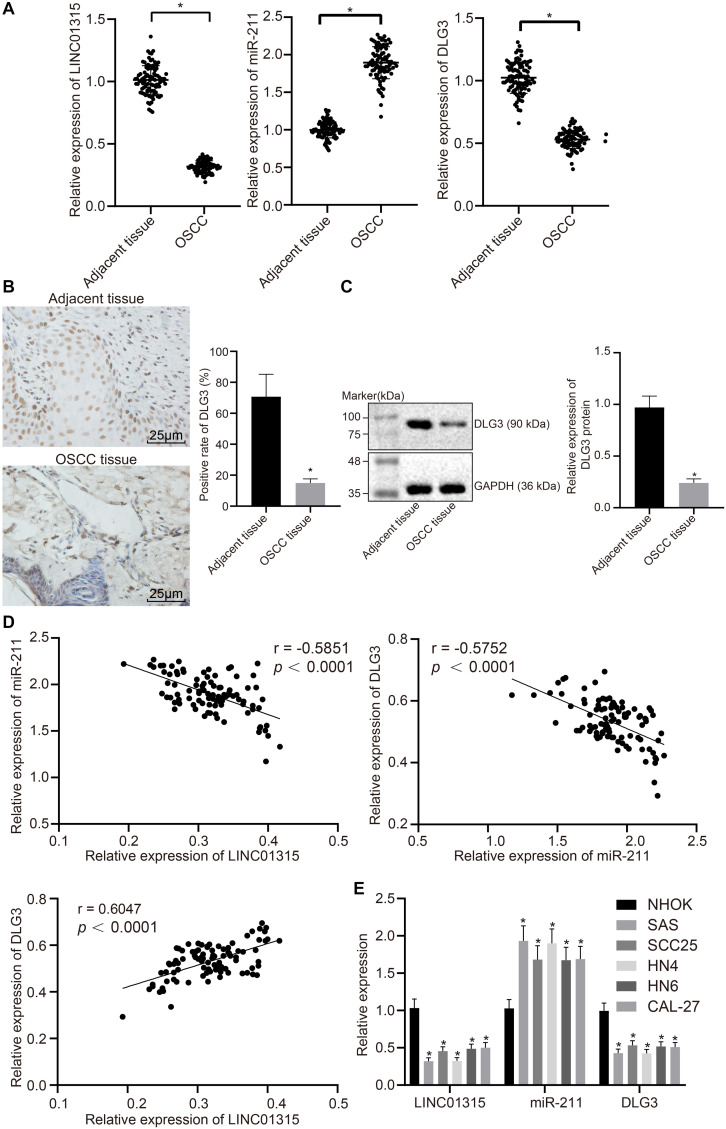
Decreased levels of DLG3 and LINC01315 but increased level of miR-211 are identified in OSCC tissues and cells. (A) Expression pattern of LINC01315, and miR-211 and DLG3 mRNA in OSCC tissues and adjacent normal tissues of patients with OSCC (n = 94) evaluated by RT-qPCR; (B) DLG3 positive rate in adjacent normal tissues and OSCC tissues (n = 94) detected by immunohistochemistry (×400); (C) DLG3 protein level in adjacent normal tissues and OSCC tissues (n = 94), as determined by western blot analysis; (D) Pearson correlation analysis among LINC01315, miR-211 and DLG3 expression in OSCC tissues (n = 94); E, Expression of LINC01315, miR-211 and DLG3 in OSCC cells (SAS, SCC25, HN4, HN6, and CAL-27) and human normal oral cell NHOK, as measured by RT-qPCR. *p < 0.05 vs. adjacent normal tissues or human normal oral cell NHOK; the data between two groups were analyzed by t-test and data among multiple groups were analyzed using one-way ANOVA. The experiment was repeated three times independently.